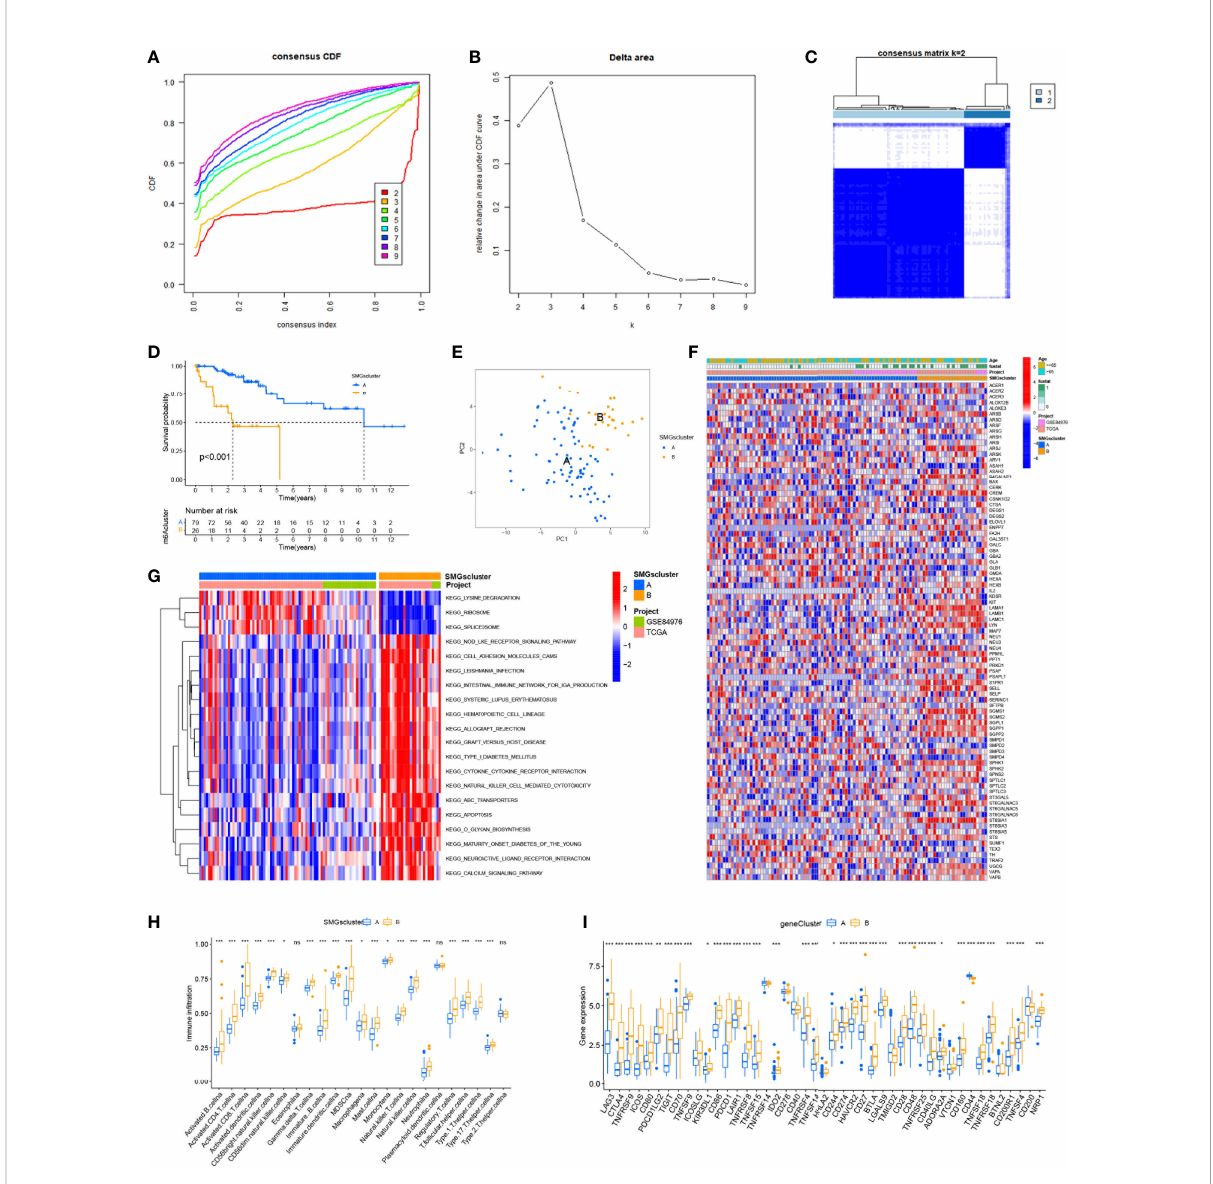
FIGURE 2 Consensus clustering identi fi ed the molecular subtypes of SMGs. (A) Consensus clustering CDF for k = 2 to 9. (B) Relative change in area under the cumulative CDF curve for k = 2 to 9. (C) Consensus matrix for k = 2. (D) The different OS between Cluster A and Cluster B. (E) PCA plot . (F) Relationships between SMGs expression and clinicopathological parameters. (G) KEGG enrichment analysis of different clusters. * P < 0.05, ** P < 0.01, *** P < 0.001, ns>0.05. (H) Immune cell scores between Cluster A and Cluster B. (I) Different expressions of immune checkpoints between Cluster A and Cluster